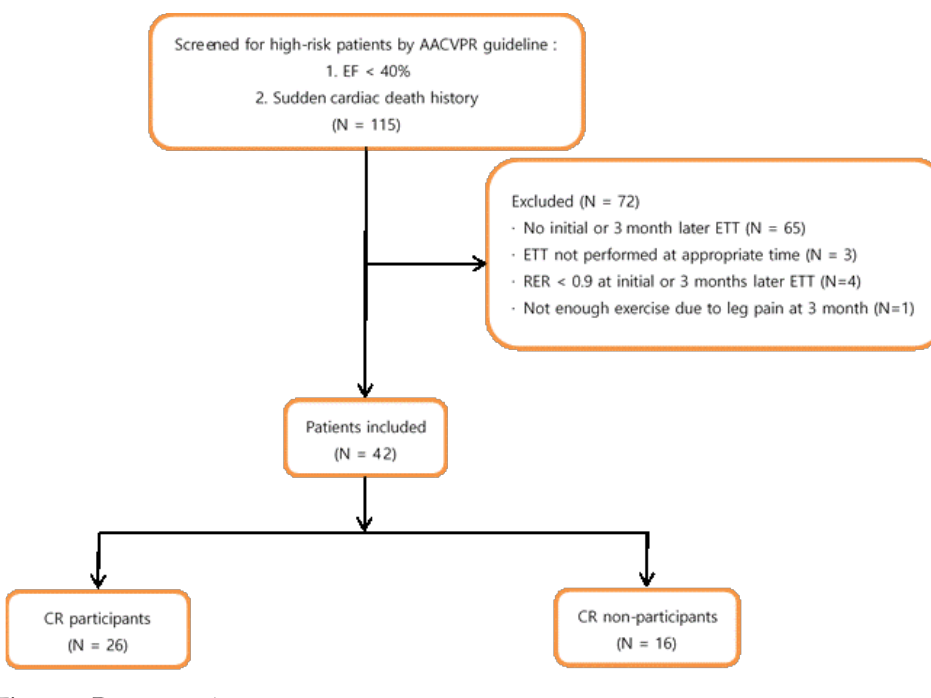
Figure 2. Data extraction process.